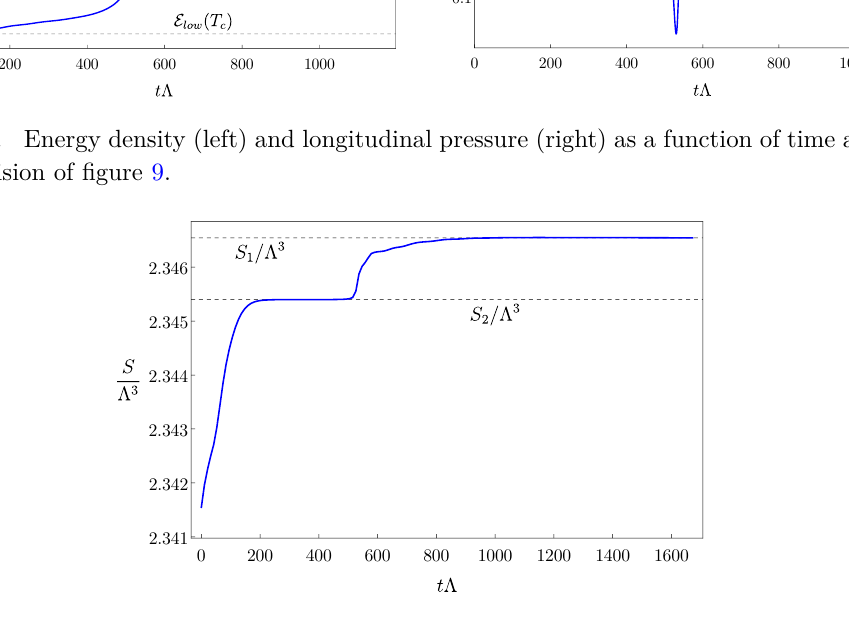
Figure 11 . Time evolution of the total entropy (per unit transverse area) for the collision of figure 9. S 2 is the entropy of a static configuration with two domains (the dashed, red curve in figure 8). S 1 is the entropy of a static configuration with the same total energy but a single